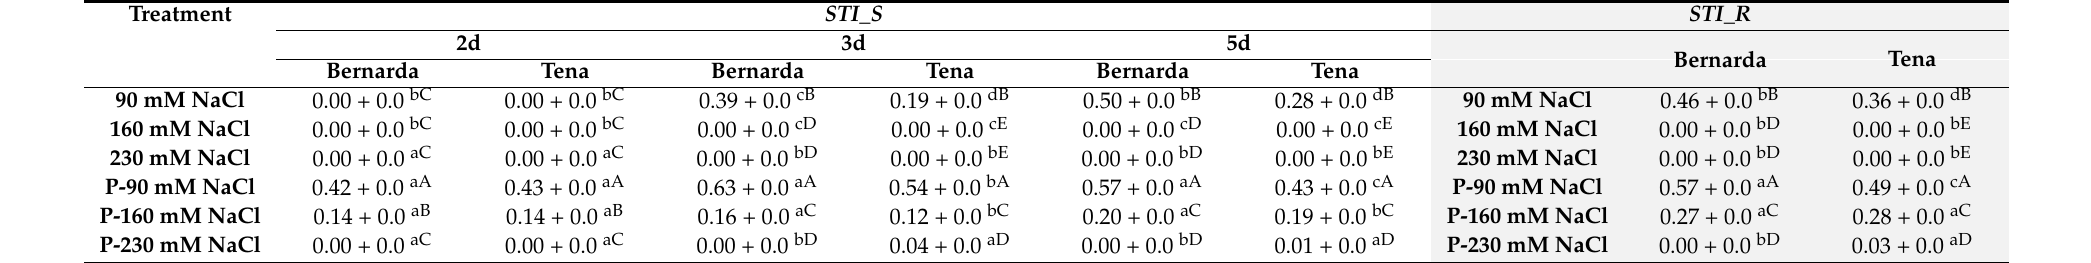
Table 8. Salt tolerance shoot index (STI_S) and salt tolerance root index (STI_R) of two wheat genotypes at 2, 3 and 5 days of growth under salt treatments (90, 160 and 230 mM NaCl), (100 seeds/repetition) ± S.D. The different capital letters indicate significances among means of different treatments within the same genotype, while lowercase letters indicate significances among means and between genotypes under the same treatment at p < 0.05 using LSD post hoc-test.